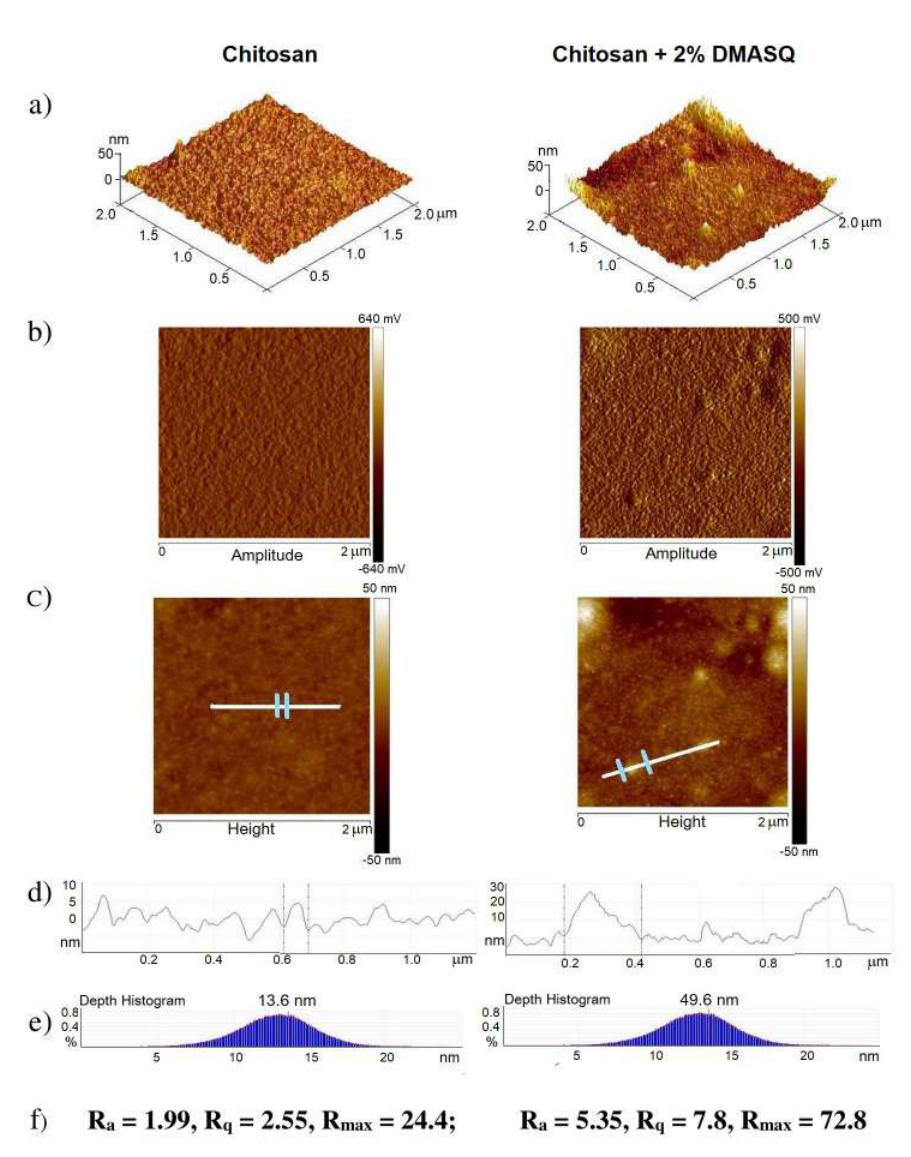
Figure 4. Semi-3D atomic force microscopy (AFM) ( a ), amplitude ( b ), topography ( c ) images; cross- sections ( d ) taken along the lines marked on the height image shown in Figure 6c; depth histograms ( e ) and roughness parameters in nm ( f ) of chitosan (left column) and DMSAQ doped chitosan (right